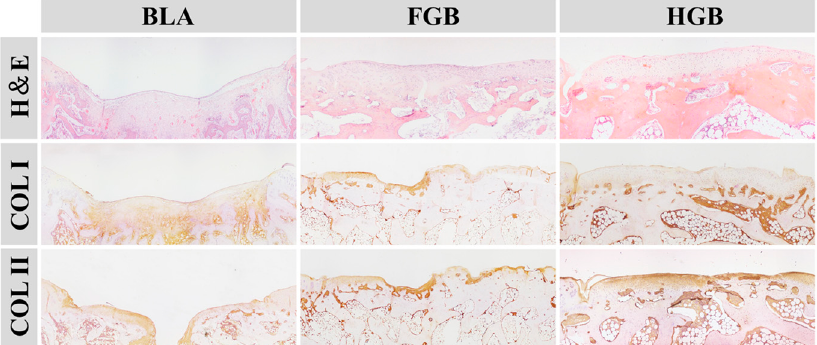
Figure 7. Histological analyses by H&E staining and immunohistochemical staining of COL II and COL I at predetermined time during the osteochondral repair in BLA, FGB, and HGB groups (Magnification: 40×). Polymers 2016 , 8 , 182